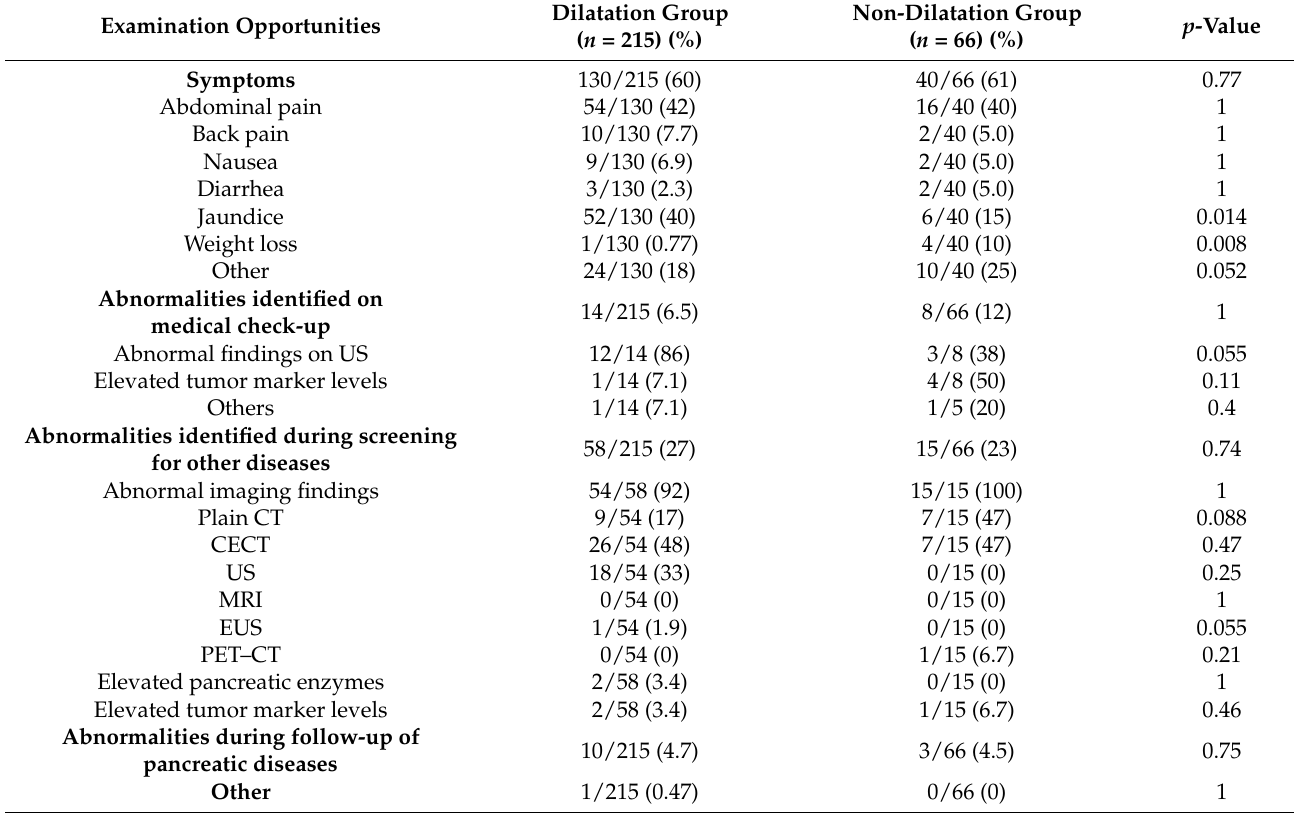
Table 2. Opportunities for medical examination.